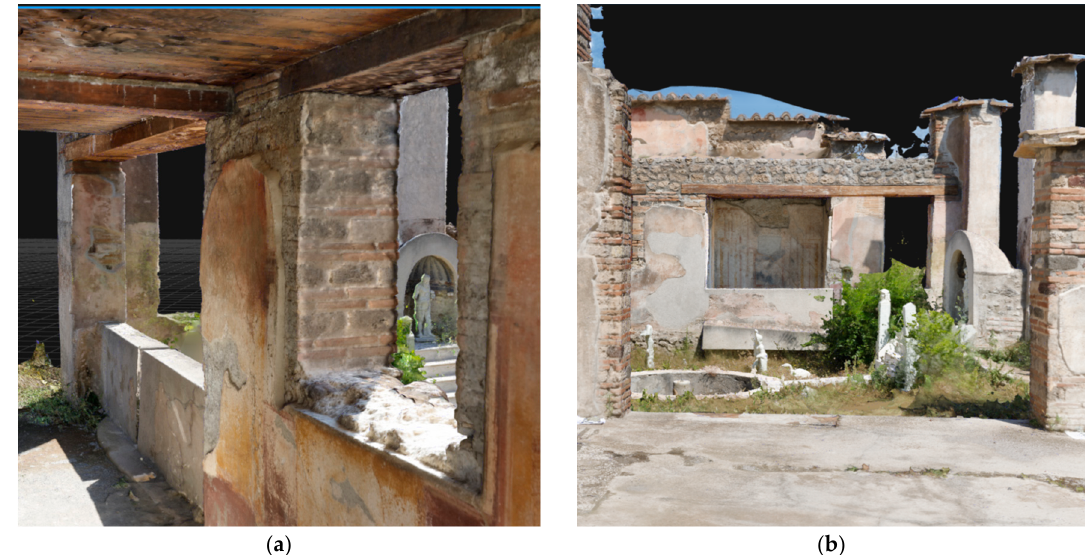
Figure 13. Screenshots from the State Model of the House of Marcus Lucretius ( a ) View into the garden from Room 19; ( b ) View into the garden from Room 25. Model Courtesy: Kelly McClinton. Image Courtesy: photos for the 3D model on concession of the Ministero dei Beni e delle Attività Culturali e del Turismo, Parco Archeologico di Pompei (used by permission).